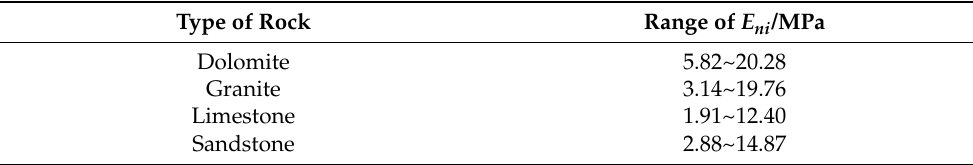
Table 3. The range of E ni values for different rock